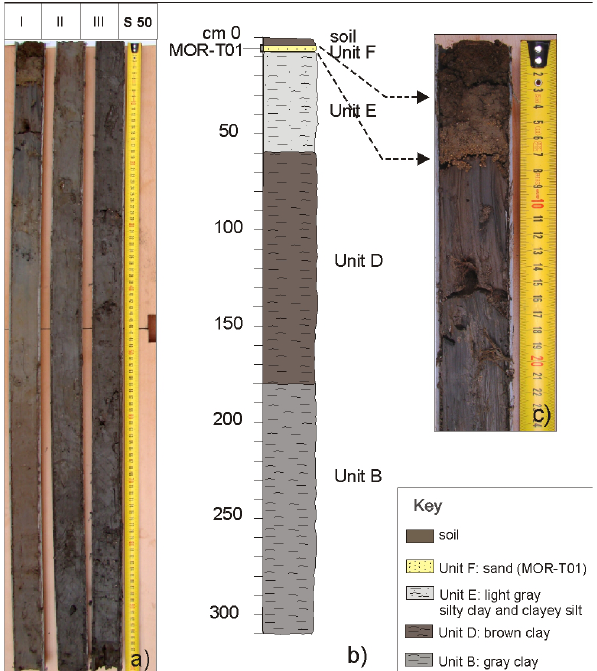
Fig. 5. (a) Photo of the S50 vibrocoring core collected at the Pan- tano Morghella. Core location is shown in Fig. 2a. Scale is in cm. Roman numbers indicate 1m cores from the top. (b) S50 log repre- senting stratigraphy of the Pantano Morghella eastern part; (c) core photo from 0 to 24cm of